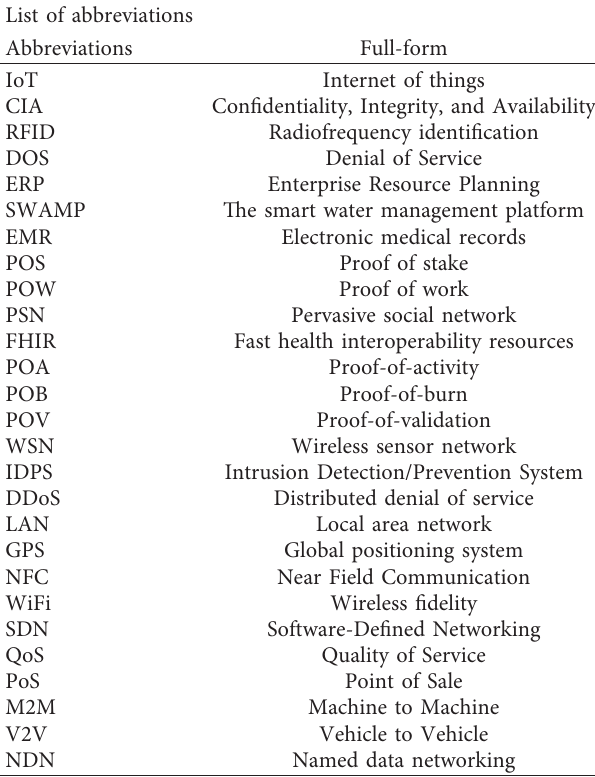
Table 8: Summarizes the list of abbreviations used in this survey. List of